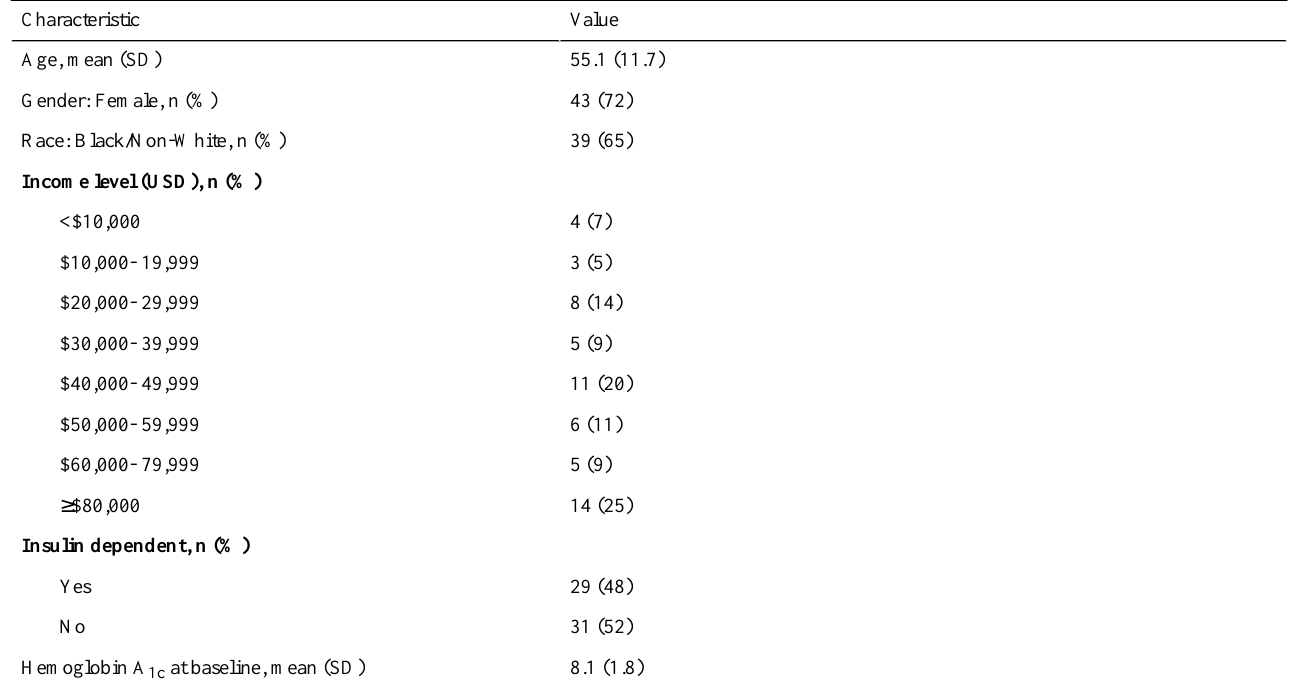
Table 2. Demographic characteristics